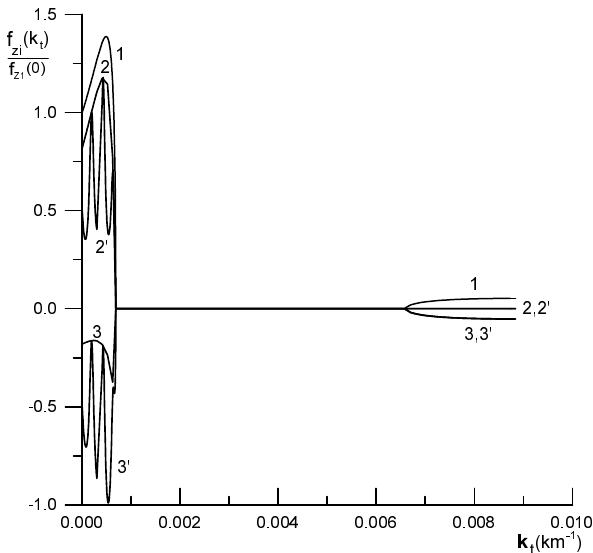
Fig. 3. Typical appearance of the energy flux densities of a monochromatic magnetosonic wave in the solar wind and in the magnetosphere in the sector 0 ≤ θ ≤ θ ∗ depending on k t . The energy flux densities are numbered: 1 – incident wave; 2 – wave transmitted to the magnetosphere at 1 = 0 and 2 0 – at 1 = 10 4 km; 3 – wave reflected from the transition layer at 1 = 0 and 3 0 – at 1 = 10 4 km.